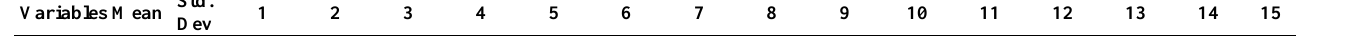
Std. Variables Mean Dev